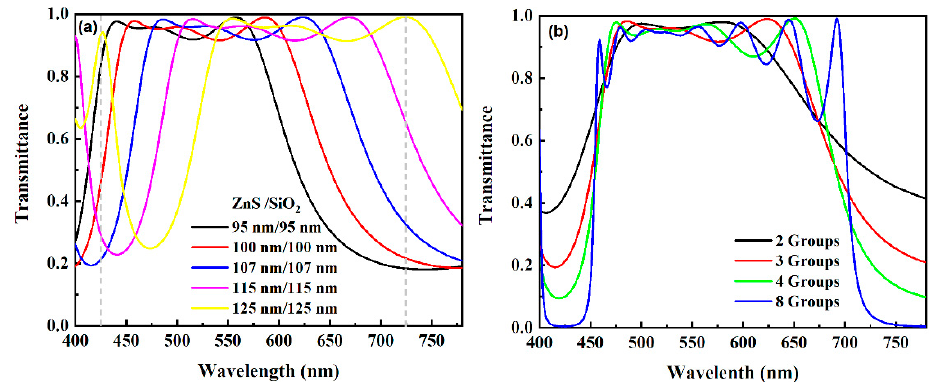
Figure 6. Transmissive spectra of the band-pass filters with different thicknesses ( a ) and numbers ( b ) of ZnS/SiO 2 pairs. In the left chart, the number of ZnS/SiO 2 is fixed to three. In the right chart, both of the thicknesses of ZnS and SiO 2 are 107 nm.